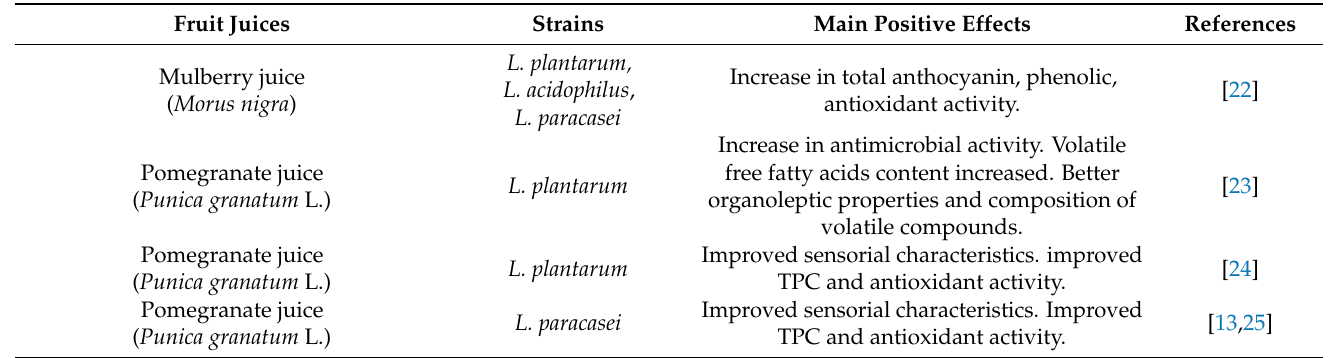
Table 1. Examples of fermented fruit juices with various LAB strains (including L. plantarum ) in single or mixed cultures with the respective